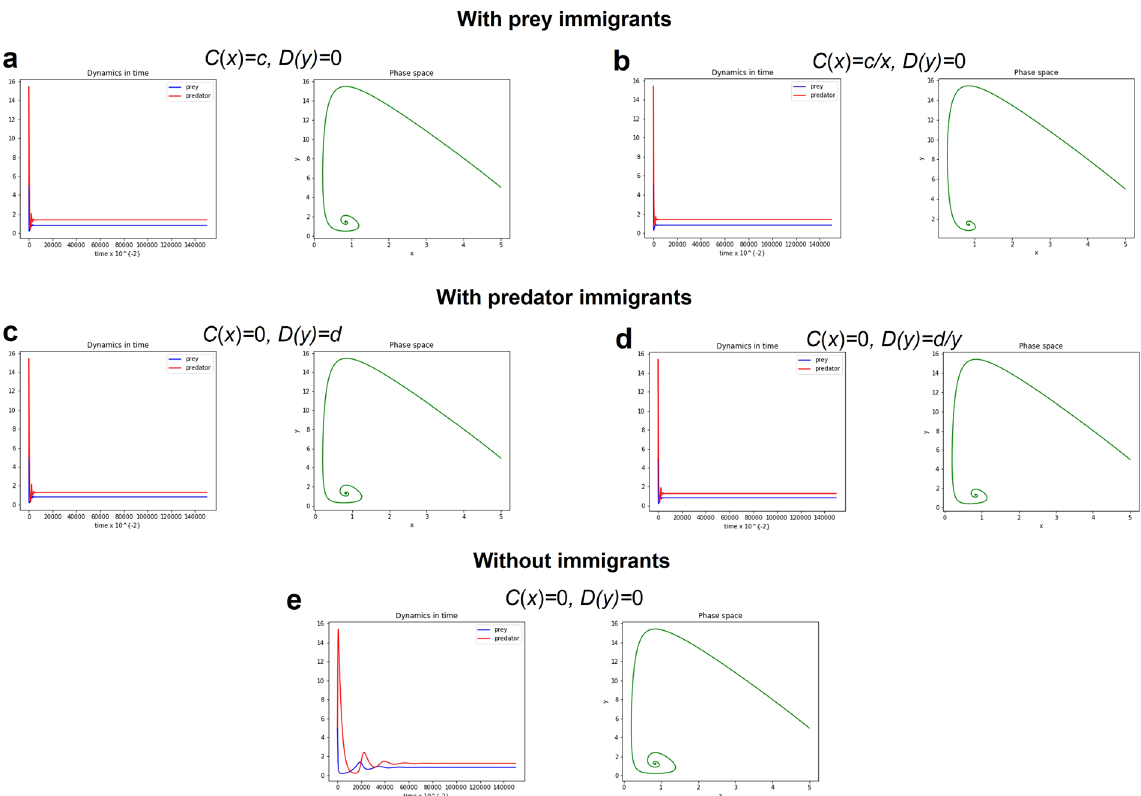
Figure 4. Phase space and long-term population dynamics of the predator-prey population described by LV system (4) with type III functional response and with/without small immigrants. Four cases of the modified LV system (4) with small immigration is compared to LV system (4) without small immigrants. Parameter values: Initial x = 5, Initial y = 5, r = 0.1, a = 0.1, b = 0.3, m = 0.2, c = 0.01, d = 0.01 and h =